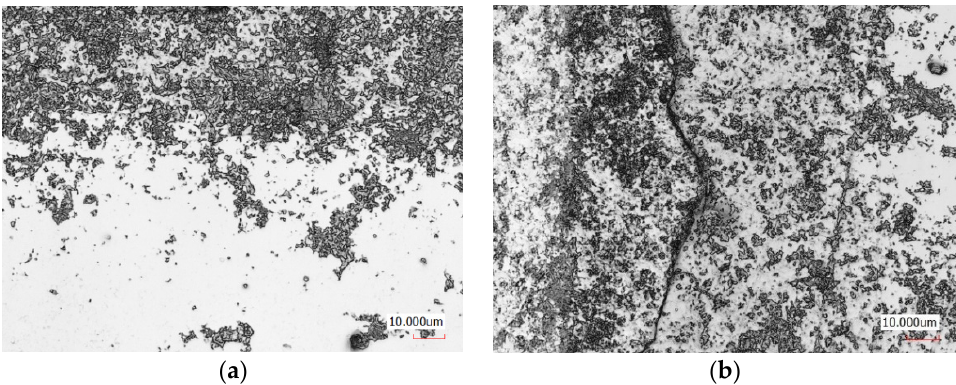
Figure 8. Boundary of worn zone: ( a ) W–B coating, ( b ) W–Ti–B coating.